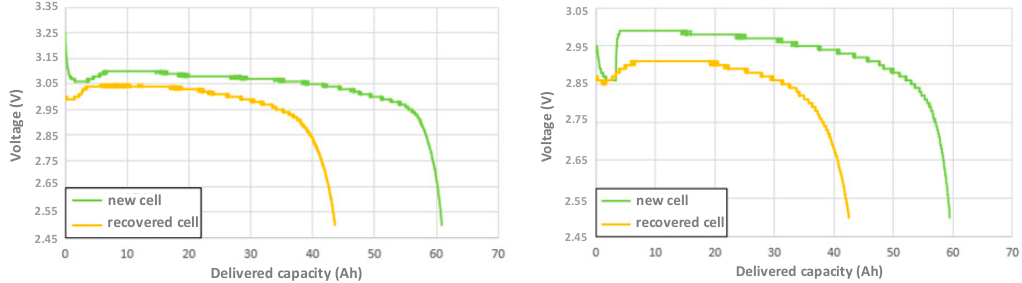
Figure 17. Voltage profile during discharge by 20 A ( left ) and 40 A ( right ) for regenerated (yellow) and referenced cell (green).